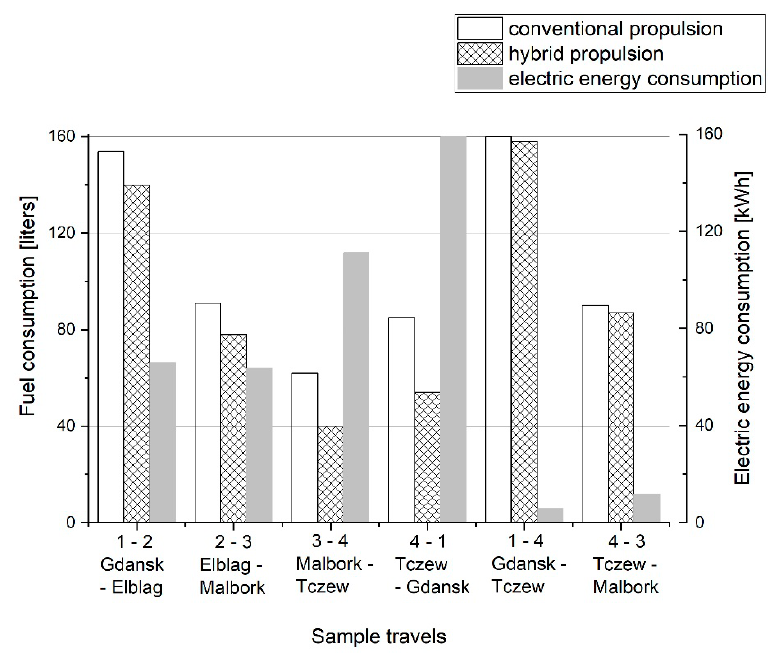
Figure 12. Calculated fuel and electricity consumption for two variants of the propulsion system (conventional and hybrid) made for 6 sample journeys.